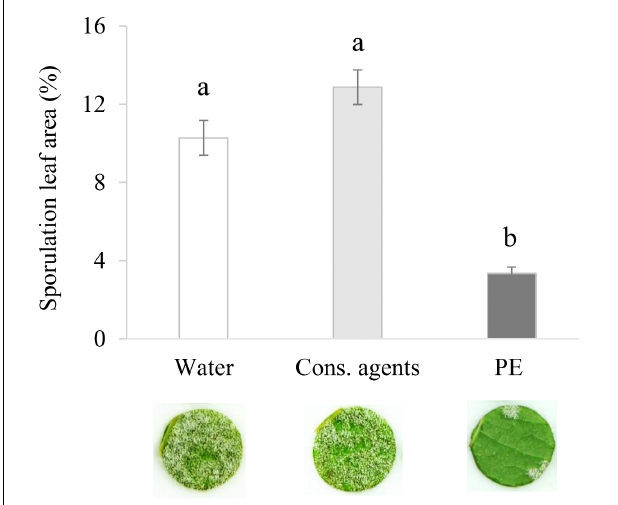
FIGURE 1 | Plant extract (PE) protects grapevine leaves against P. viticola. Plants grown in greenhouse conditions were treated by PE at 5 g L − 1 , or equal volumes of conserving (cons.) agents or water, and inoculated at 48 hpt with a suspension of P. viticola sporangia (2.10 4 sporangia mL − 1 ). At 6 dpi, 40 disks per condition (i.e., five disks per leaf, with two leaves per plant, and four plants per condition) were punched out. Leaf disk sporulating area was evaluated at 7 dpi by image analysis. Results correspond to the mean ± confidence interval of four independent biological repetitions. Significant differences ( p ≤ 0.05) were identified with Kruskal–Wallis coupled with Dunn’s multiple comparison test. Conditions with different letters are significantly